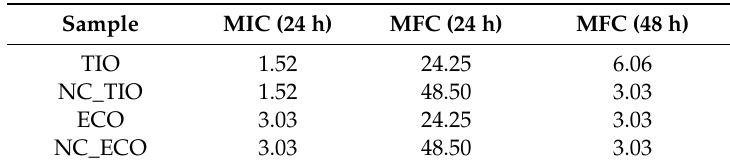
Table 4. MIC and MFC ( µ g / mL) of the systems against C.